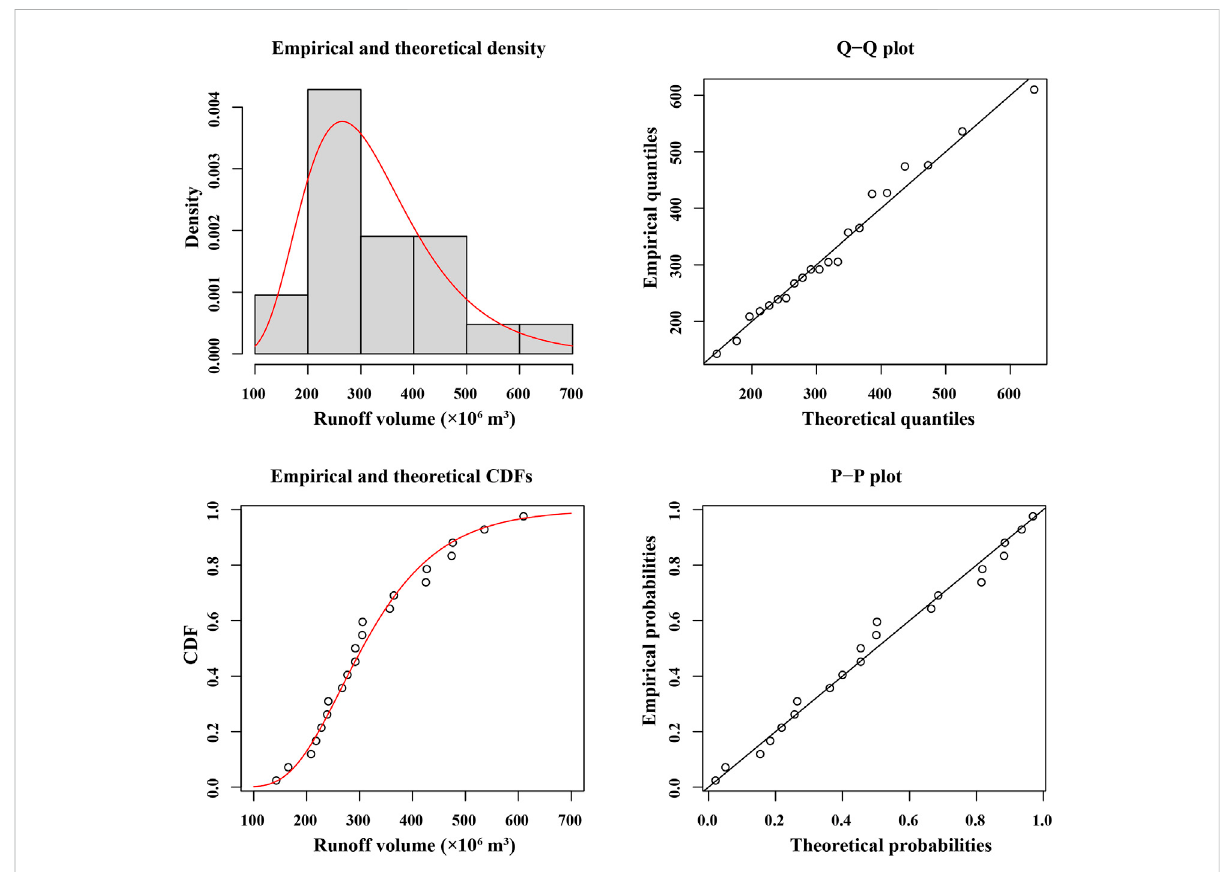
FIGURE 4 Fitting distribution results of source 2 with log-normal